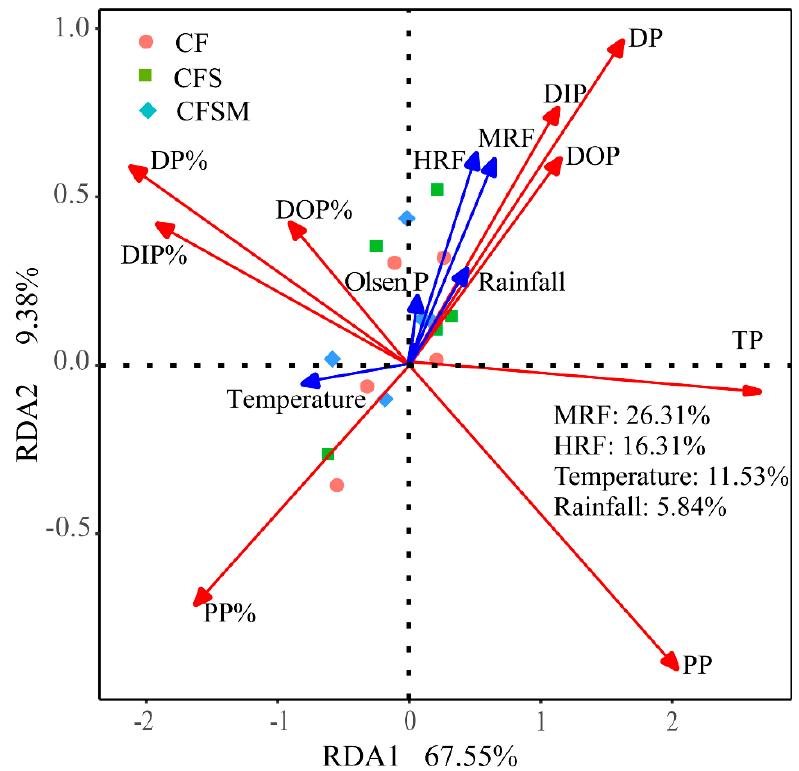
Figure 6. Redundancy analysis (RDA) of environmental factors of P loss for different treatments. The P loss is indicated by red lines, including total P (TP), dissolved P (DP), particulate P (PP), dissolved inorganic P (DIP), dissolved organic P (DOP), PP%, DIP%, and DOP% in leachates. The environmental factors indicated by blue lines include rainfall, MRF (moderate rainfall frequency), HRF (heavy rainfall frequency), temperature (soil surface temperature), and Olsen P (0.5 M NaHCO 3 extracted P, referred to as soil − available P). Different treatments are represented by three kinds of colored shapes.